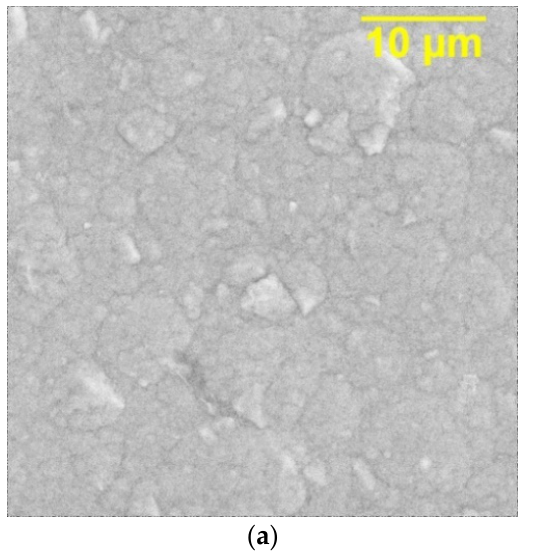
Figure 4. SEM images of Ni ( a ) and Ni–GO CEC ( b ) deposited at cathode current density i c = 10 A/dm 2 (magnification × 5000).